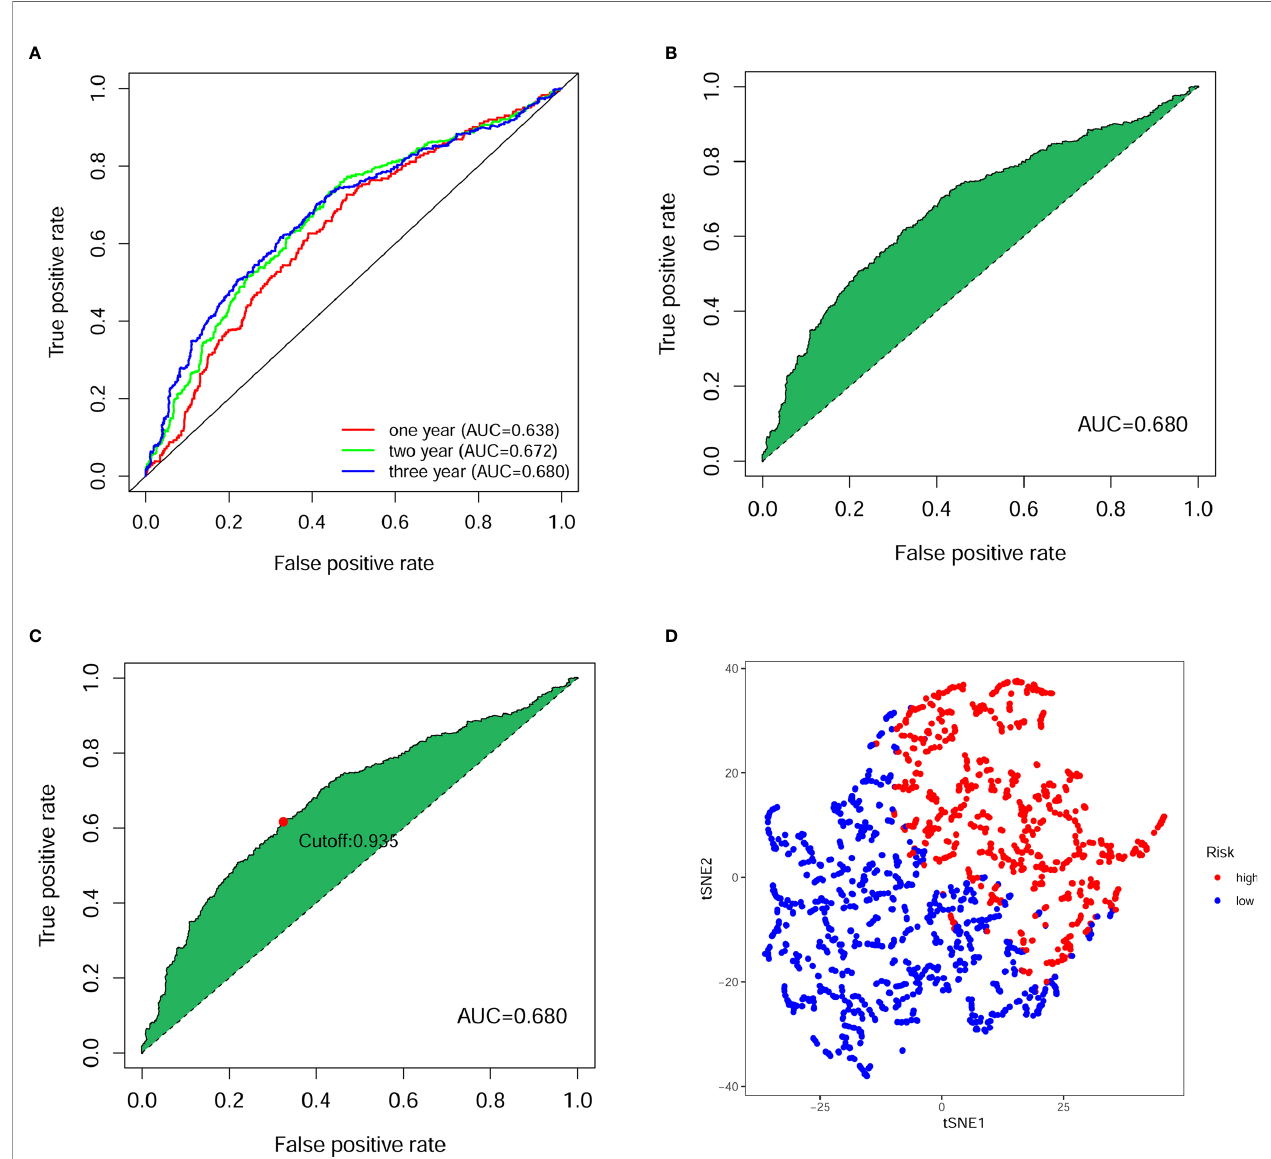
FIGURE 3 | Evaluation of prognostic model for digestive system pan-cancer. (A) The ROC analysis showed that the AUCs of 1-, 2- and 3-year survival of patients with digestive system cancer were greater than 0.6. (B) The AUC for ROC analysis of the optimal model was 0.680. (C) The cut-off point calculated using the AIC was the maximum in fl ection point of the optimal model. (D) The tSNE down-scaling analysis showed strong heterogeneity between high- and low-risk groups distinguished using truncation